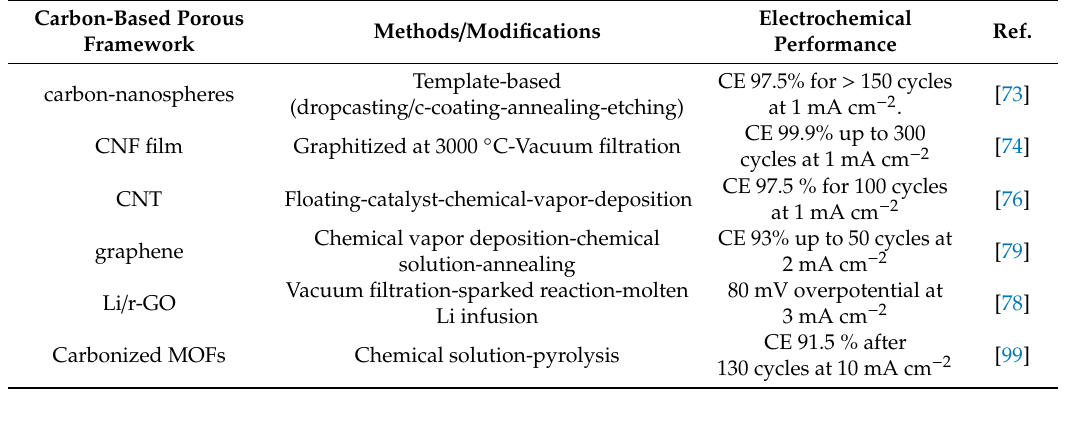
Table 2. Summary of the carbon-based porous framework in LMBs.